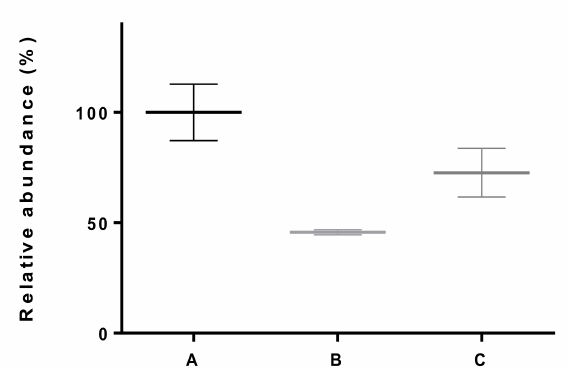
Figure 3. Effect of snap-freezing with liquid nitrogen on the DFCA concentration in a 1000 ng g − 1 spiked fecal sample. Comparison of immediately extracted and analyzed samples (A, n = 3, mean% = 100 ± standard deviation)), with snap-frozen and thawed samples (B, n = 3, mean% = 47 ± standard deviation)) and with snap-frozen and unthawed samples (C, n = 3, mean% = 72 ± standard deviation)).